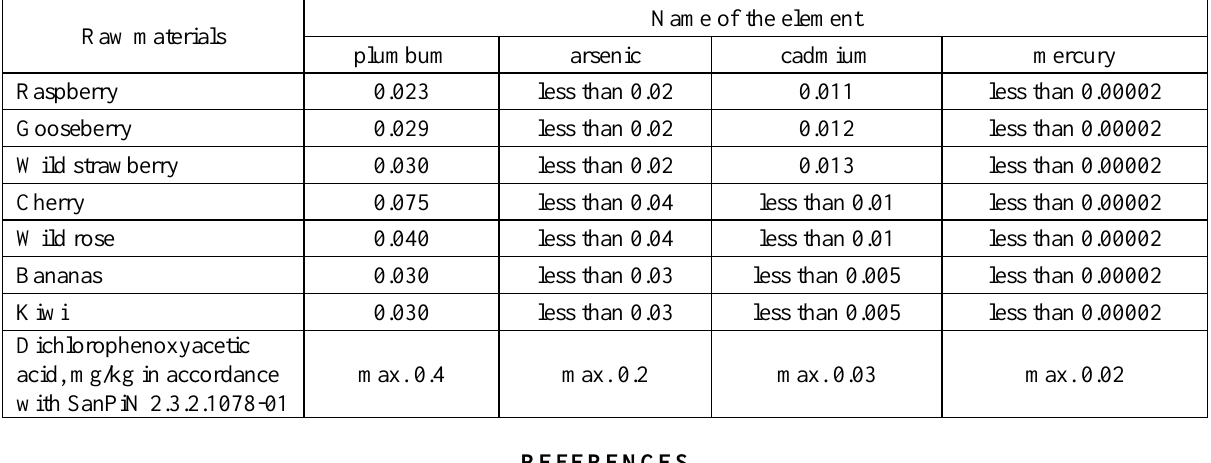
Table 12. Content of toxic elements in berries and fruits Raw